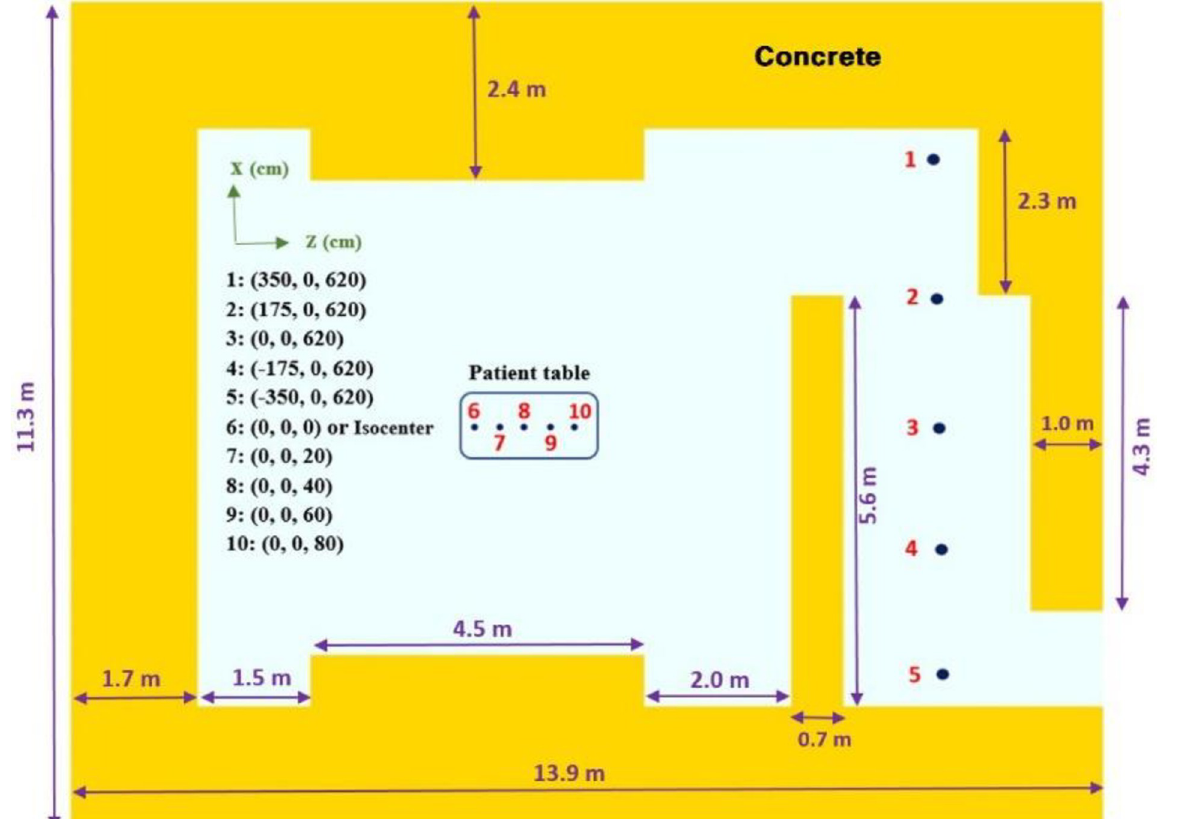
Fig 2. Scheme of a typical radiotherapy room simulated by MCNPX 1 . The thicknesses of the floor and ceiling were 1.0 m and 1.7 m, respectively.